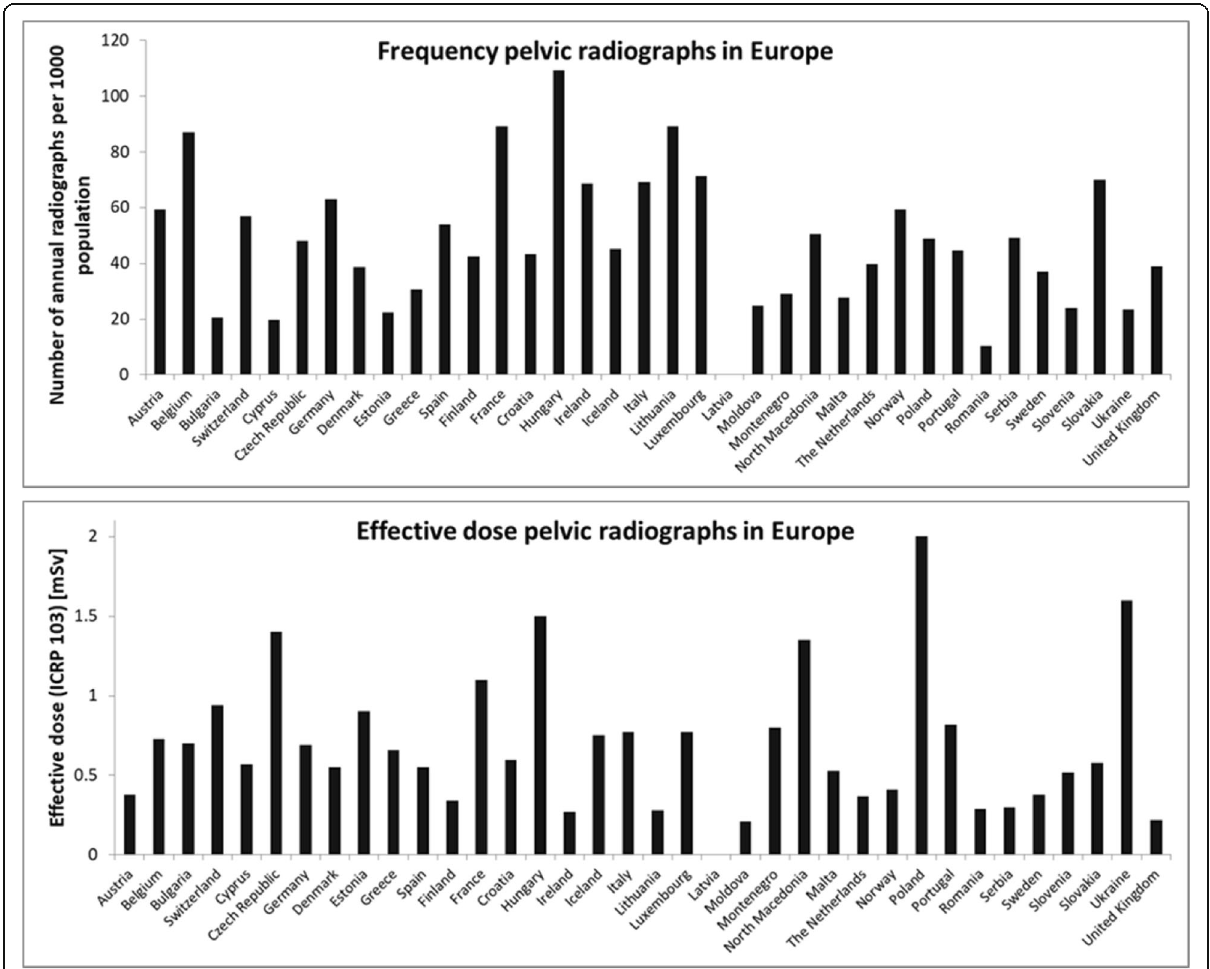
Fig. 2 Annual frequency of pelvic radiographs per 1000 population in European countries (top). Effective dose of pelvic radiographs in European countries (bottom). According to RP180, data from 2007 to 2010